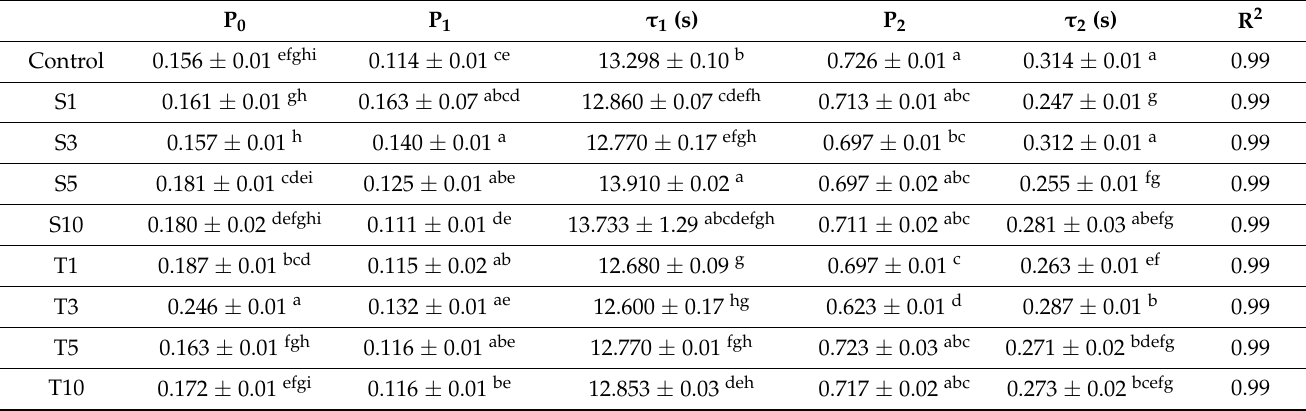
Table 1. Parameters of Weichert’s modelling of oleogel